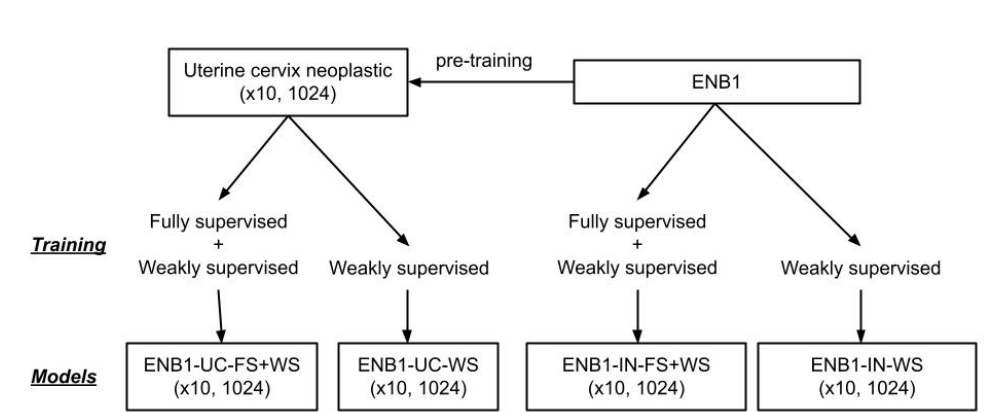
Figure 2. Training method and deep learning models overview. We performed training using two different weight initialisations: ImageNet (IN) and pre-training on a uterine cervix (UC) neoplastic ( × 10, 1024) dataset from a previous study. We used two different approaches for training: fully supervised (FS) and weakly supervised (WS) learning. This resulted in a total of four models, all trained at magnification × 10 and tile size 1024 × 1024px: ENB1-UC-FS+WS, ENB1-UC-WS, ENB1-IN-FS+WS, and